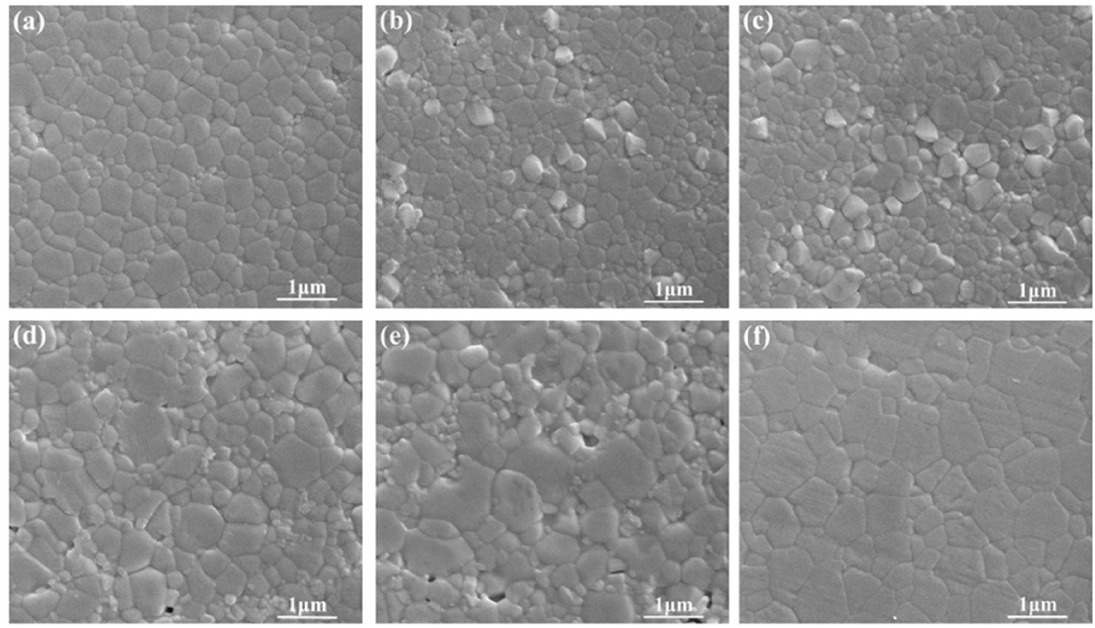
Figure 3. The microstructure of sintered BZT ceramics by spark plasma sintering (SPS) and annealed BZT ceramics at different temperature: ( a ) the sintered sample without annealing; ( b ) 1200 ° C-12 h; ( c ) 1250 ° C-12 h; ( d ) 1300 ° C-12 h; ( e ) 1350 ° C-12 h; ( f ) 1400 ° C-12 h.